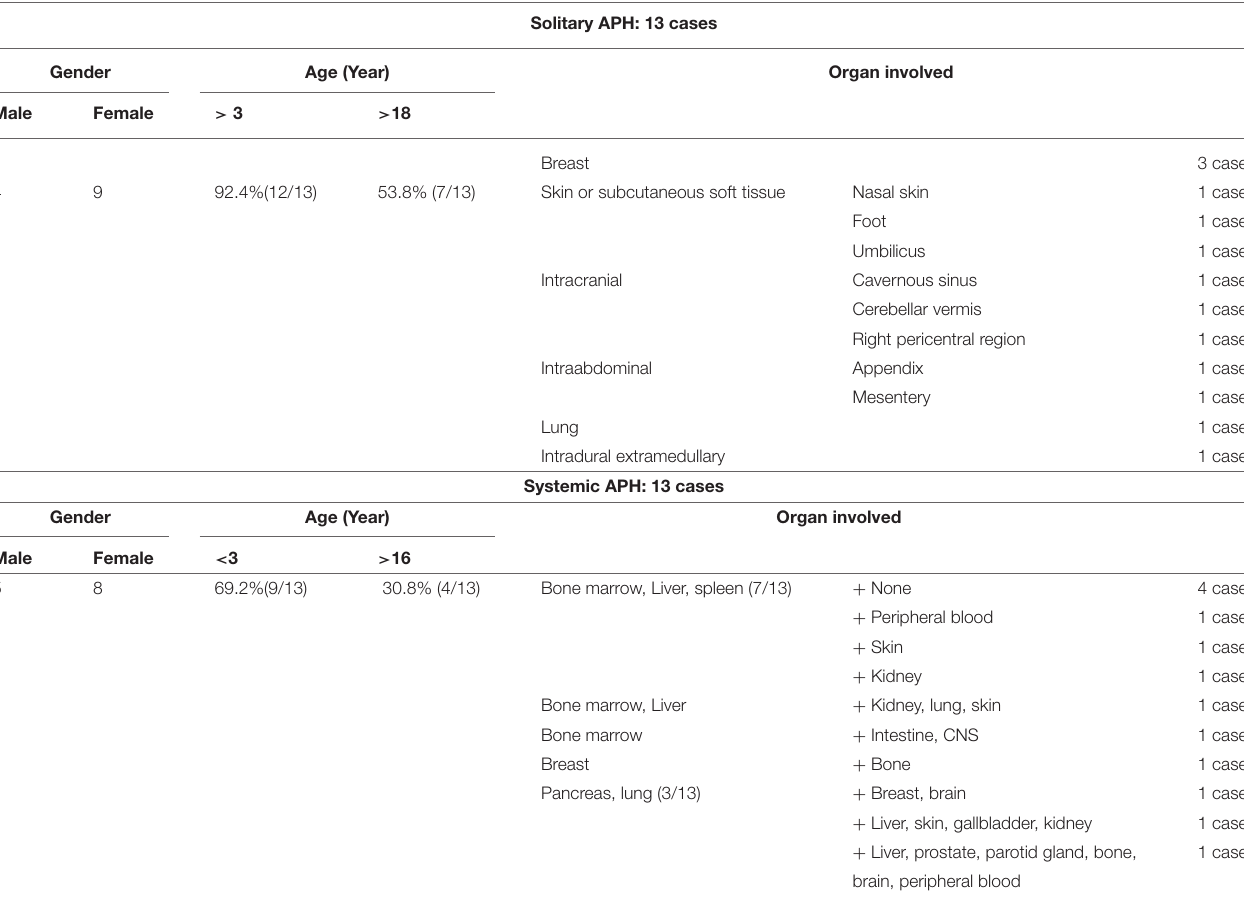
TABLE 1 | Summary of clinicopathologic findings for patients with solitary and systemic